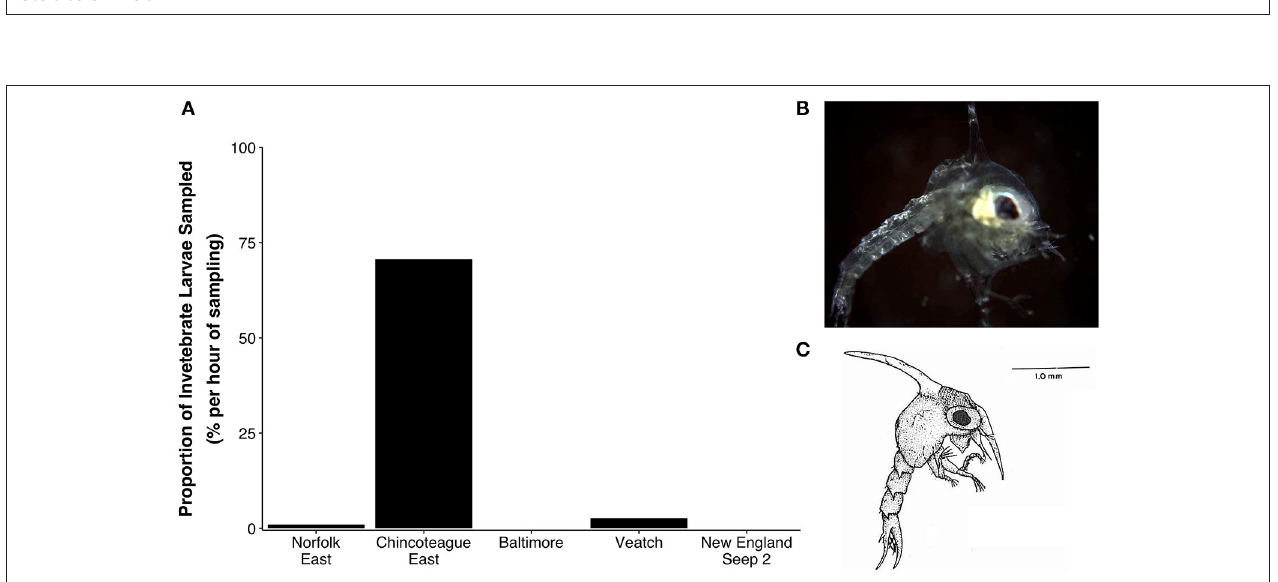
FIGURE 7 | Zoea larvae. (A) Zoea larvae sampled per hour at 5–10m above bottom (mab), presented as a percentage of all invertebrate larval forms. (B) Image of a zoea larva (one of 37 individuals) collected 5 mab at Chincoteague East. (C) Illustration of a first stage red crab ( Chaceon quinquedens ) zoea larva from Perkins (1972).